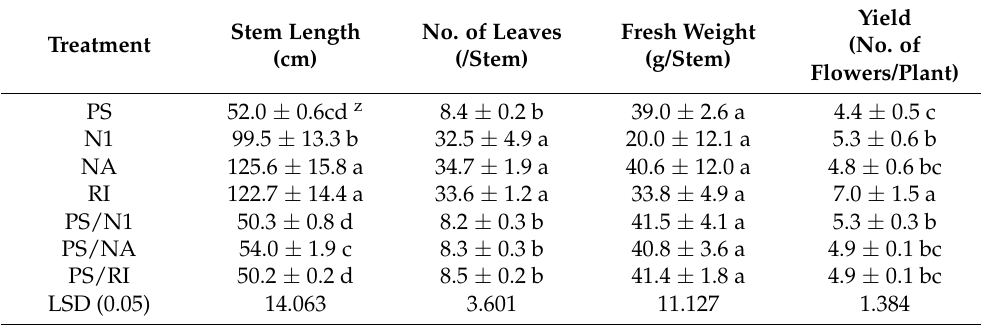
Table 3. The yield and flower shoot qualities of scion, rootstocks, and grafted cut rose flowers grown in the greenhouse during the summer season. Yield Stem Length No. of Leaves Fresh Weight (No. of Treatment (cm) (/Stem) (g/Stem) Flowers/Plant)